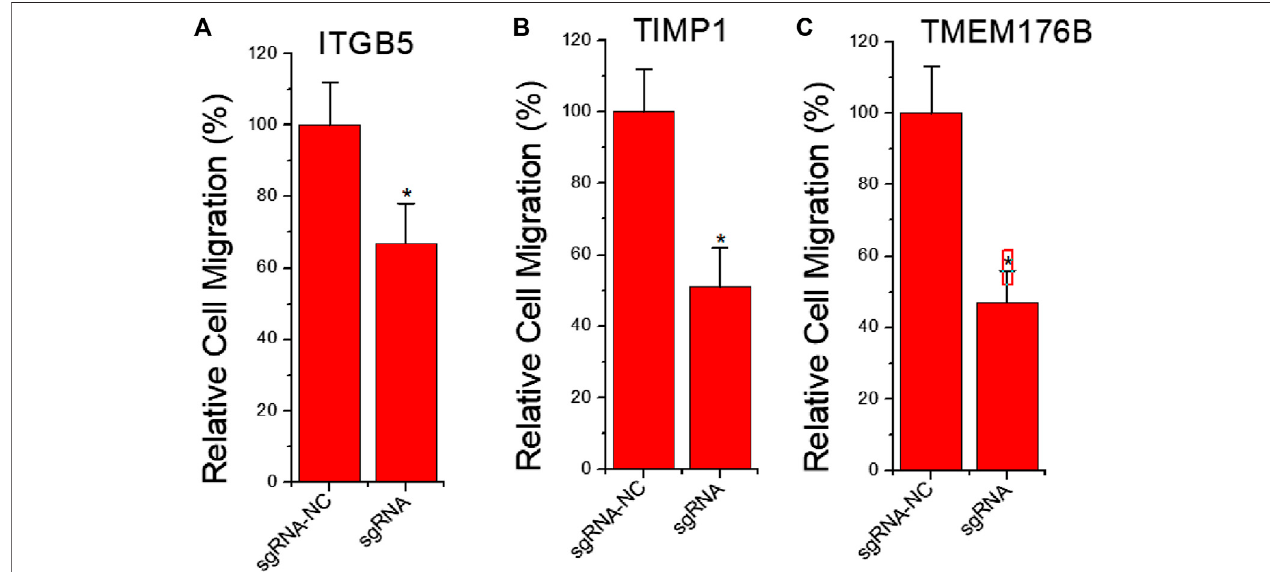
FIGURE 3 | The effects of knockdown of ITGB5 or activation of TIMP1 and TMEM176B expression on cell migration. LNCap cells were transfected by CRISPRi or CRISPRa systems and cell migration assay revealed that knockdown of ITGB5 (A) or activation of TIMP1 (B) and TMEM176B (C) expression inhibited the migration rate of LNCap cells.